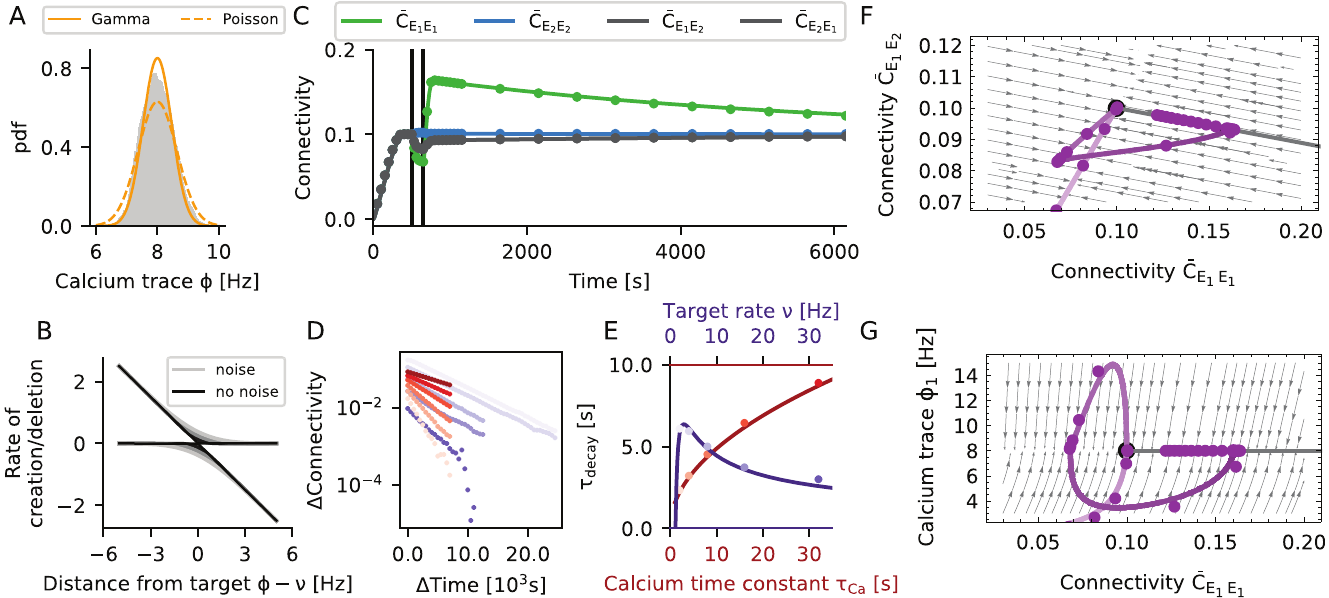
Fig 5. Noisy spiking induces fluctuations that lead to memory decay. (A) The gray histogram shows the distribution of calcium levels for a single neuron across 5000 s of simulation. The yellow lines resulted from modeling the spike train as a Poisson process (dotted line) or a Gamma process (solid line), respectively. (B) The rate of creation or deletion of synaptic elements depends on the difference between the actual firing rate from the target rate (set-point), for different levels of spiking noise. The negative gain (slope) of the homeostatic controller in presence of noise is transformed into two separate processes of creation and deletion of synaptic elements. In the presence of noise (grey lines, lighter colors correspond to stronger noise), even when the firing rate is on target, residual fluctuations of the calcium signal induced a continuous rewiring of the network, corresponding to a diffusion process. (C) If noisy spiking and the associated diffusion was included in the model, our mean-field theory matched the simulation results very well. This concerns the initial decay, the overshoot and subsequent slow decay. Vertical lines indicate the beginning and the end of the stimulation. (D) Change in connectivity during the decay period, for different values of the calcium time constant (different shades of red, from light to dark τ Ca = 1, 2, 4, 8, 16, 32 s, ρ = 8 Hz) and the target rate (different shades of purple, from light to dark ρ = 2, 4, 8, 16, 32 Hz, τ Ca = 10 s). We generally observed exponential relaxation as a consequence of a constant rewiring rate. (E) Time constant of the diffusive decay as a function of the calcium time constant and the target rate. Lines show our predictions from theory, and dots represent the values extracted from numerical simulations of plastic networks. The decay time τ decay increases with The memory was generally more stable for small target rates ν , but collapsed for very small rates. This indicates an optimum for low firing rates, at about 3 Hz. (F, G) Same phase diagrams as shown in Fig 4E and 4F, but taking noise into consideration. (F) The spiking noise compromises the stability of the line attractor, which turns into a slow manifold. (G) The relaxation to the high-entropy connectivity configuration during the decay phase is indeed confined to a constant firing rate manifold.